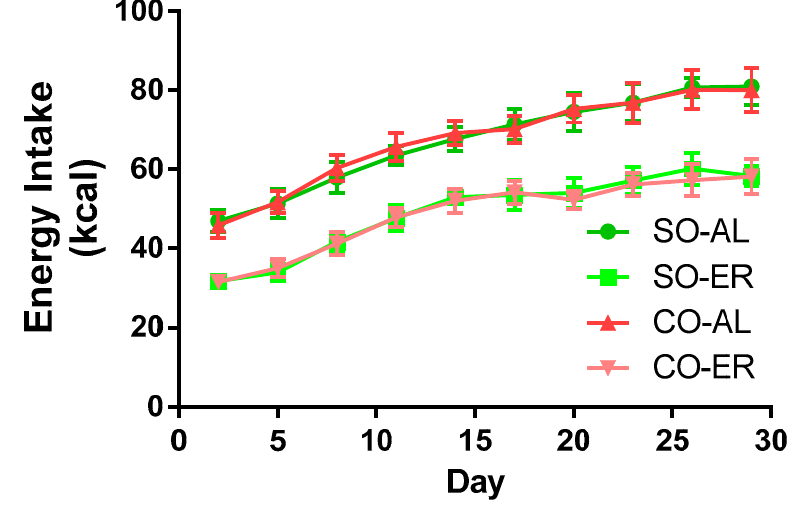
Figure 1. Energy intake of the experimental groups. Growing male rats at 3 weeks of age were fed AIN93G-based diets formulated to provide 16% of energy as fat derived from SO or CO. SO-ER and CO-ER rats were individually fed 75% of the diet amount of the SO-AL and CO-AL rats, respectively. For clarity of the graph, data are presented for every 3rd day on diet. Comparisons of food consumption by two-way ANOVA demonstrated no effect of oil type. Data are reported as mean ± SD; n = 8. AL: ad libitum; CO: corn oil; ER: energy restriction; SO: soybean oil.